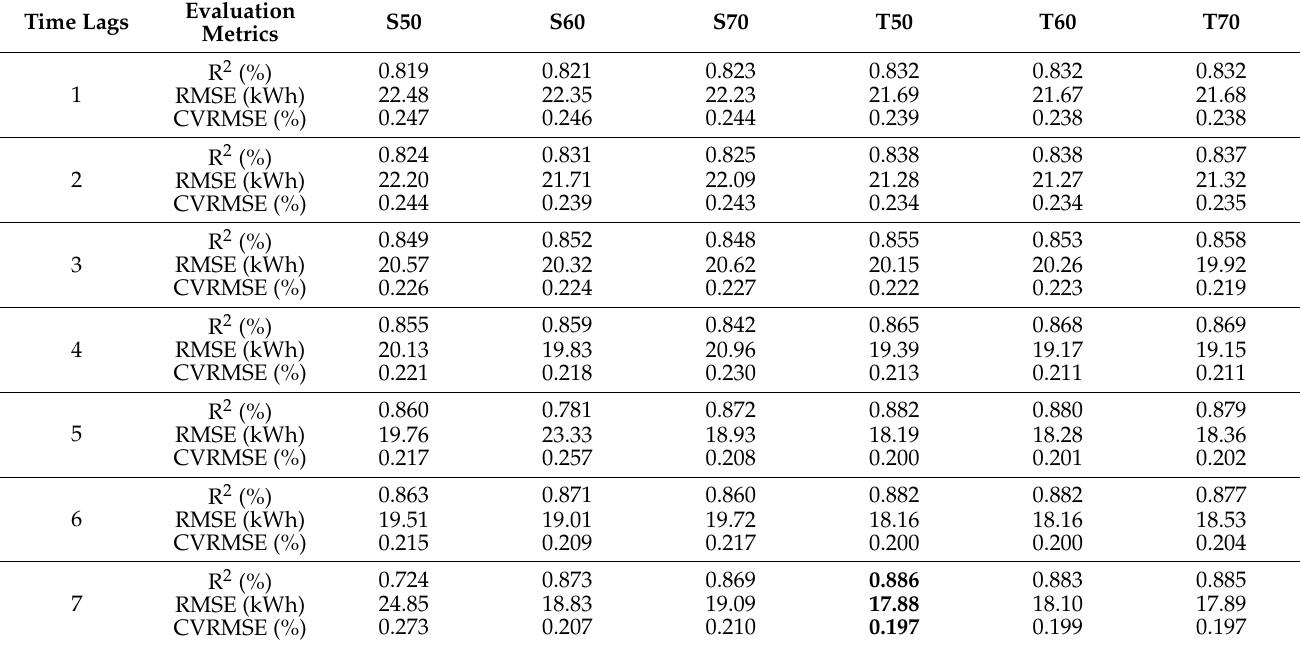
Table 6. Performance in the metrics evaluated when forecasting the energy consumption of the HVAC, using different time lags and HPs, applying the C3 configuration.